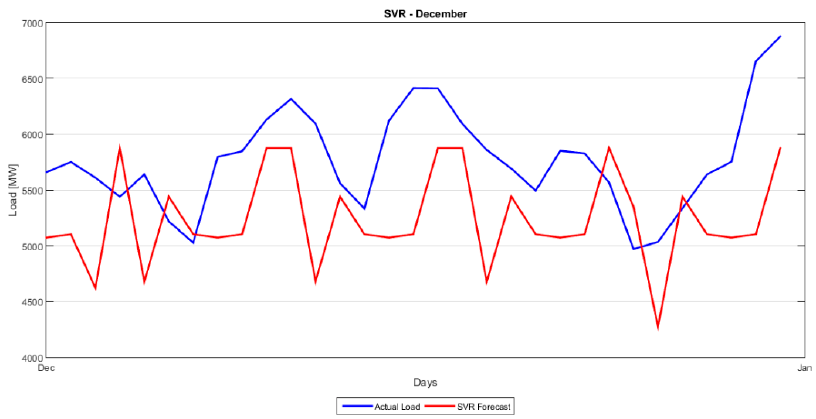
Figure 27. SVR forecast for December 2014.